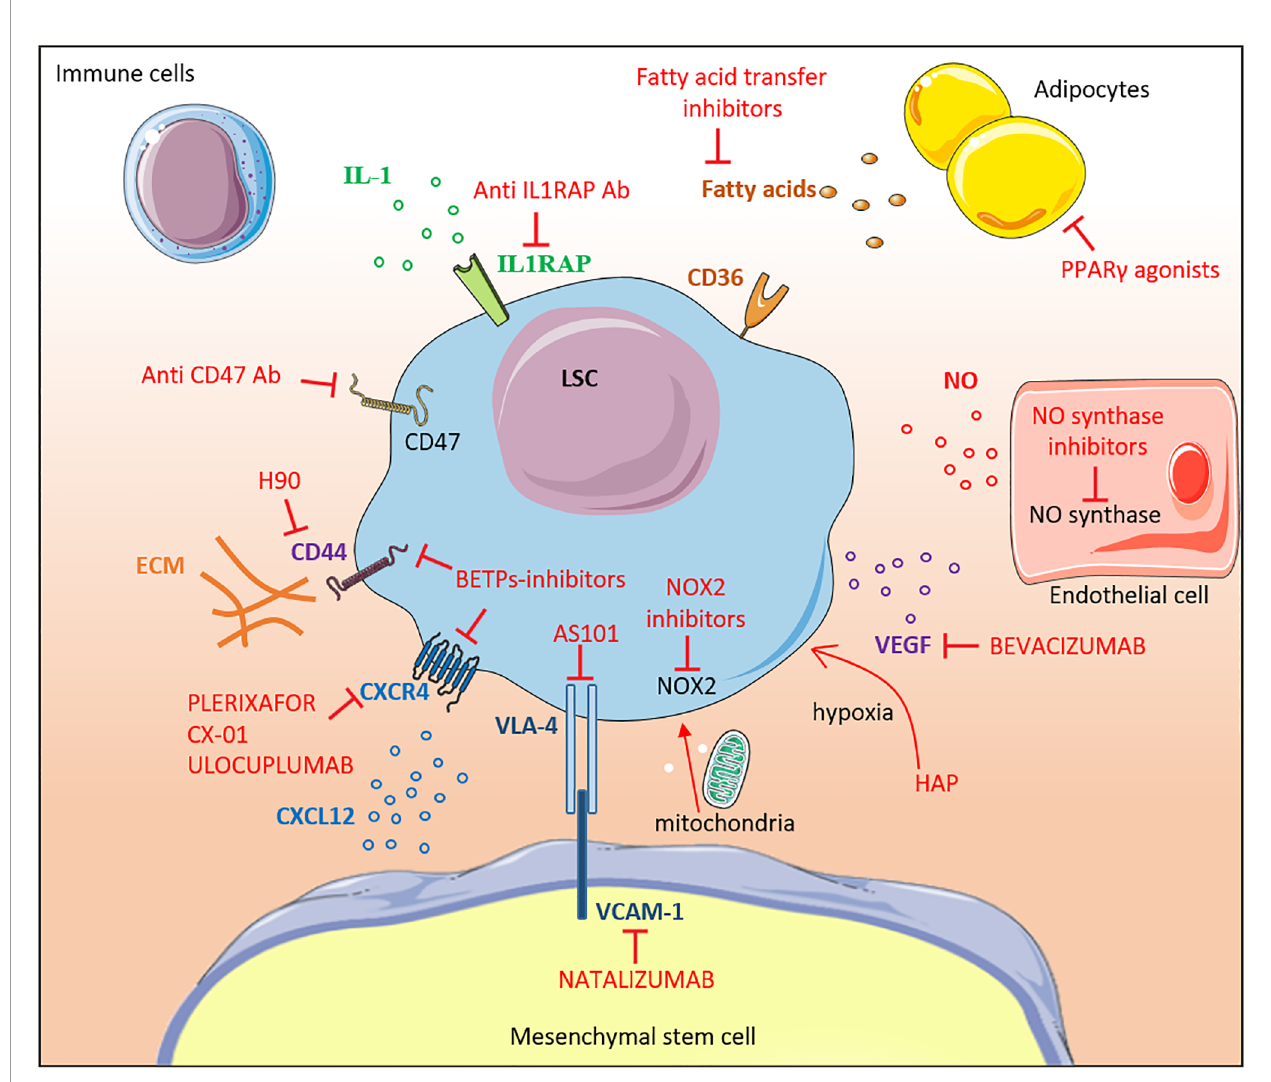
FIGURE 2 | Therapeutic targeting of the leukemic niche. The different molecular interactions between LSCs and the bone marrow niche constituents are shown. Inhibitors are labeled in red. Most of the drugs shown in the fi gure are under pre-clinical or early clinical development. IL-1, interleukine-1; Ab, antibody; CD, cluster of differentiation, FA, fatty acid; LSC, leukemic stem cell; MSC, mesenchymal stem cell; NOX2, NADPH oxidase 2; NO, nitric oxide; ECM, extracellular matrix; VEGF, vascular endothelial growth factor; HAP, Hypoxia-activated prodrugs; PPAR g , Peroxisome Proliferator-activated Receptor gamma; VCAM-1, Vascular Cell Adhesion Molecule-1; BETPs, Bromodomain Extra-Terminal